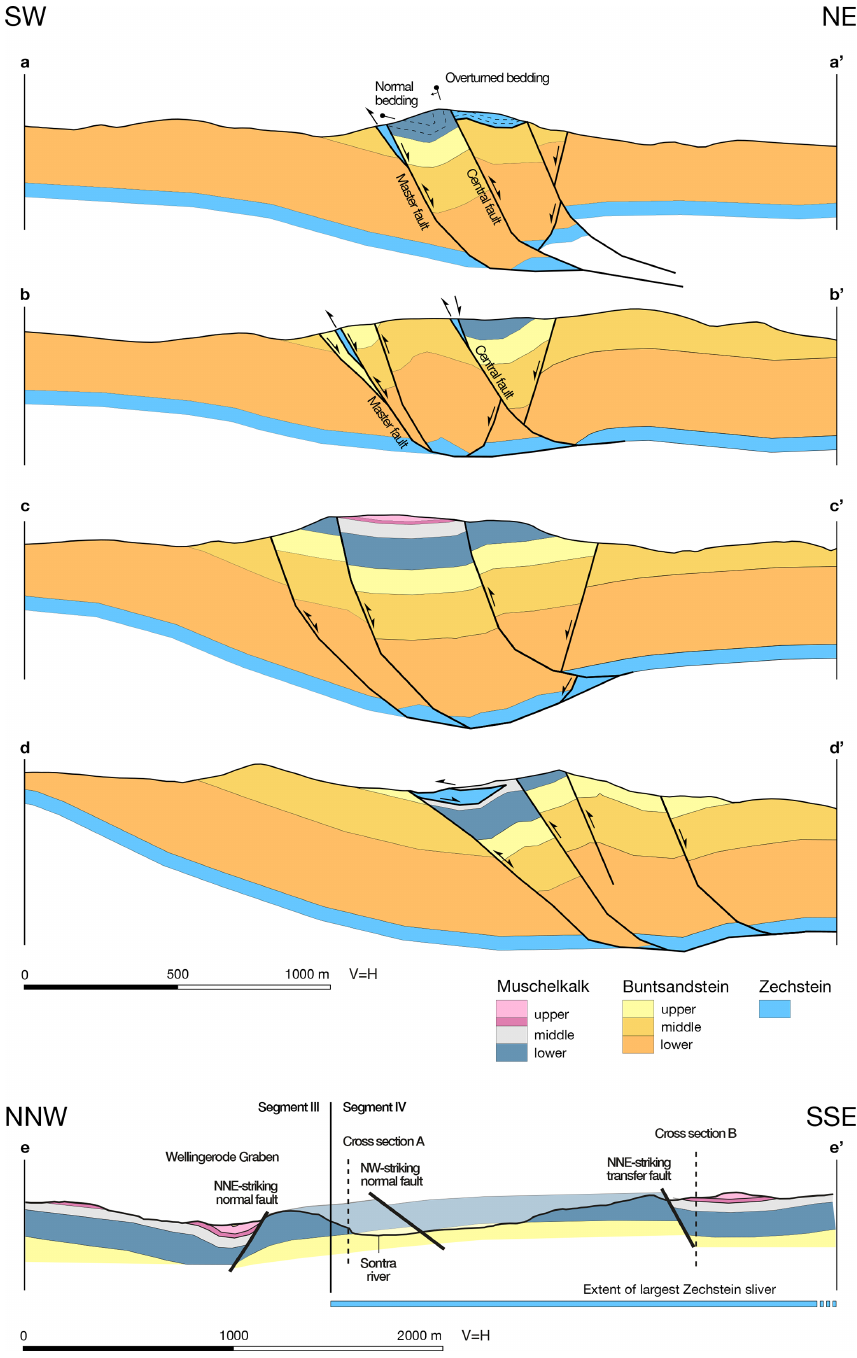
Figure 8. Sections a–d: conceptual cross sections of the Sontra Graben northwest and southeast of the balanced cross sections in Fig. 7. Basic features of our forward model and balanced cross sections were adopted to interpret surface observations in these sections. Section e: longitudinal cross section illustrating the effect of varying erosion levels on the appearance of the graben. Only the hanging wall of the boundary fault to the depth of the upper Buntsandstein is shown. Notice the axial syncline of the Wellingerode half-graben, which in this location forms the fold interference pattern with the axial syncline of the Sontra Graben (Fig. 3). Section traces are shown in Fig.